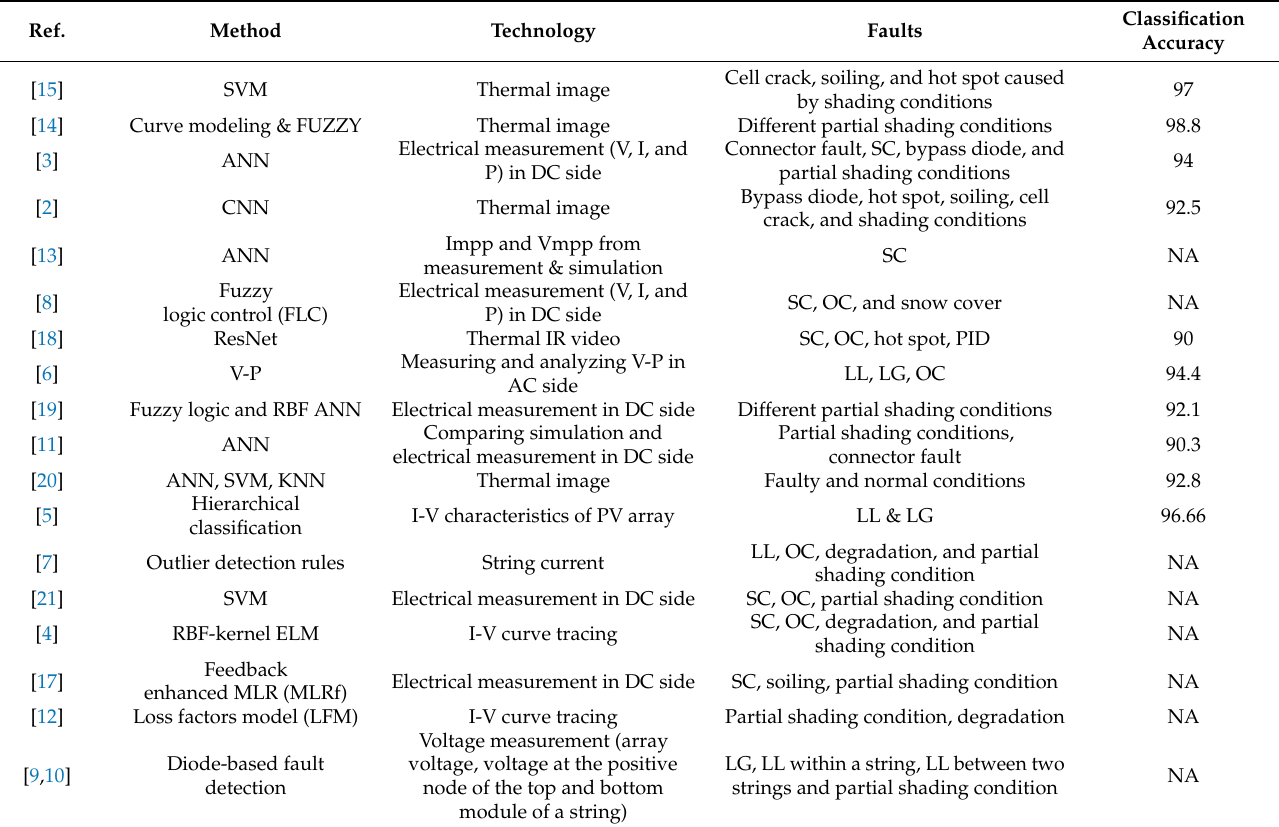
Table 1. Review of various types of PV fault detection using different methods and technology.